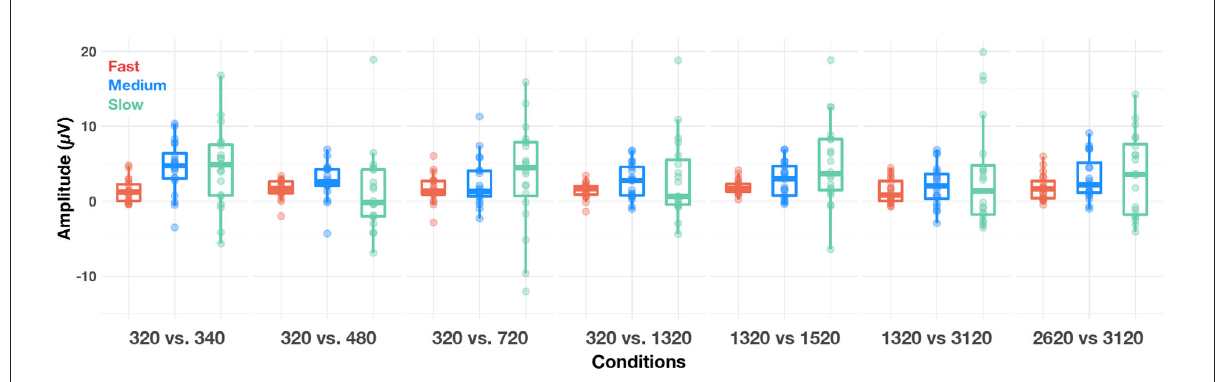
FIGURE6 Boxplots of amplitude of the P1 (cortical) response evoked in each condition, at fast (red dots), medium (blue dots) and slow (green dots) alternating rates, recorded at Cz. The whiskers indicate values that fall within 1.5 times the interquartile range. Dots falling outside the whiskers are